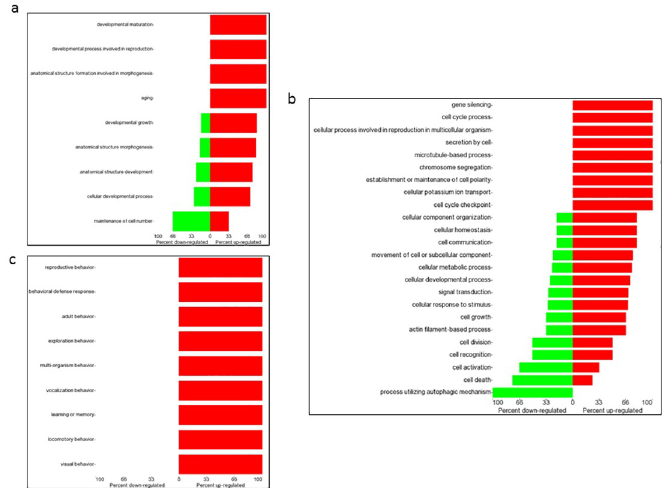
Fig 4. Forest plot of GO for DEGs in biological processes in male Cln3 Δ ex7/8 mouse brain. Gene expression in GalCer- versus vehicle-treated Cln3 Δ ex7/8 male mouse brain. The criterion for differential expression assumes a p- value < 0.05. Forest plots of biological processes including (a) developmental, (b) cellular, and (c) behavioral processes depict percentage of down- (green) or up-regulated (red) genes in each category. https://doi.org/10.1371/journal.pone.0239537.g004 term depression”, “estrogen signaling pathway”, “synaptic vesicle cycle”, “ErbB signaling path- way”, and “prion diseases”. All significant canonical pathways identified in male Cln3 Δ ex7/8 mouse brain appear in S5 Table. Upregulated genes involved in these pathways included Grm1 , Prkacb , Braf , Jak1 , Gabbr1 , Dnm3 and Atp6v0a1 (S2 Table). Downregulated genes comprised Mapk8 and C1qb (S3 Table). In female Cln3 Δ ex7/8 mouse brain, significant pathways included “prolactin signaling pathway”, “selenium compound metabolism”, and “steroid biosynthesis”